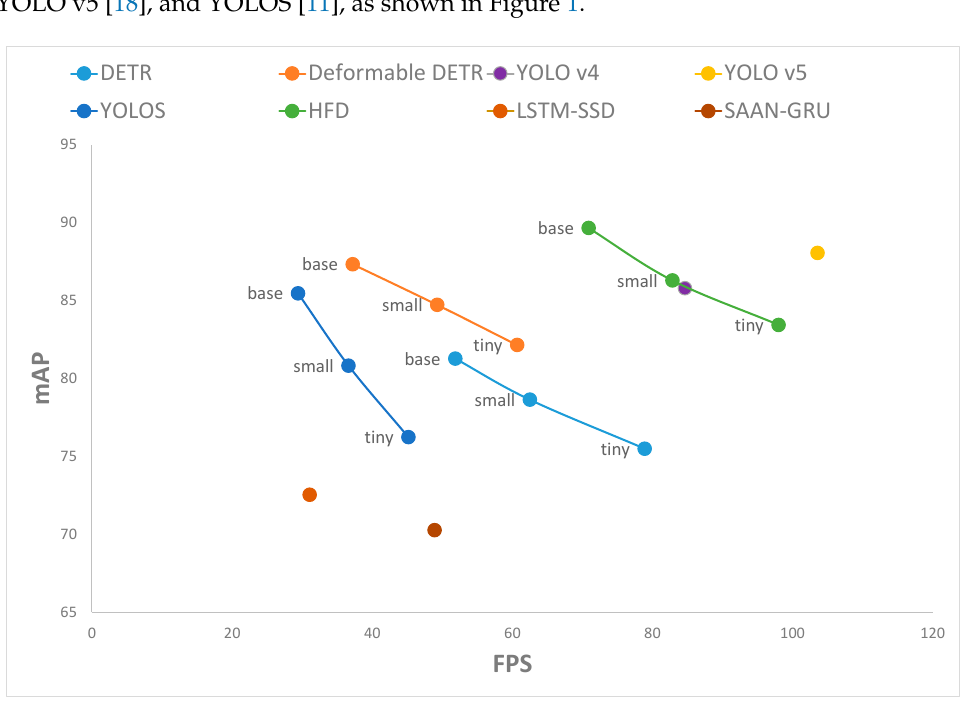
Figure 1. Capabilities of recent object detectors in terms of mean average precision (mAP) and frames per second (FPS).